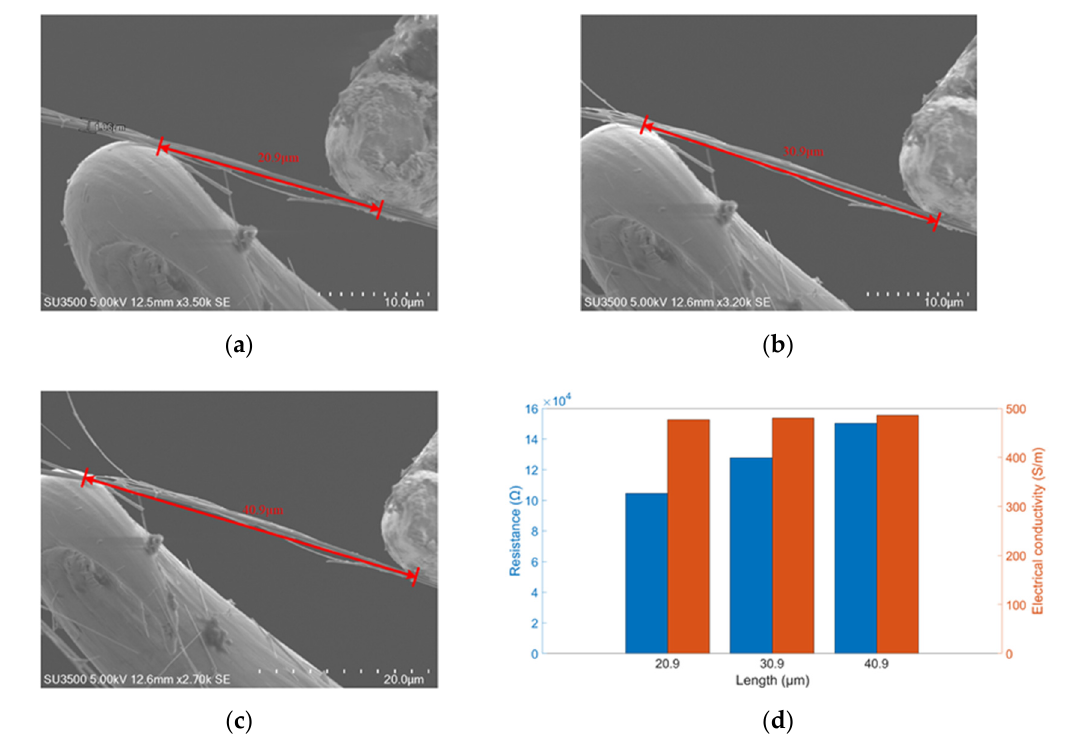
Figure 9. Electrical conductivity measurement. ( a – c ) Lengths of ZnO nanowires are 20.9, 30.9, 40.9 μ m with same diameters of 1.06 μ m. ( d ) Blue bars represent resistance and red bars represent electrical conductivity correspond to ZnO nanowires with length of 20.9 μ m, 30.9 μ m and 40.9 μ m.